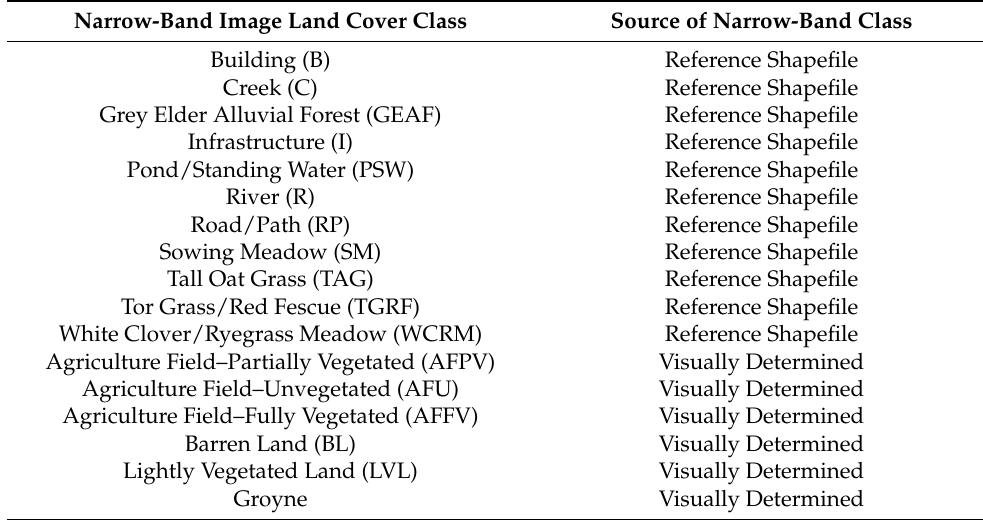
Table 2. Narrow-band classes used in classifications of the River Gail study area. (Note: Abbreviations for land cover classes are shown in